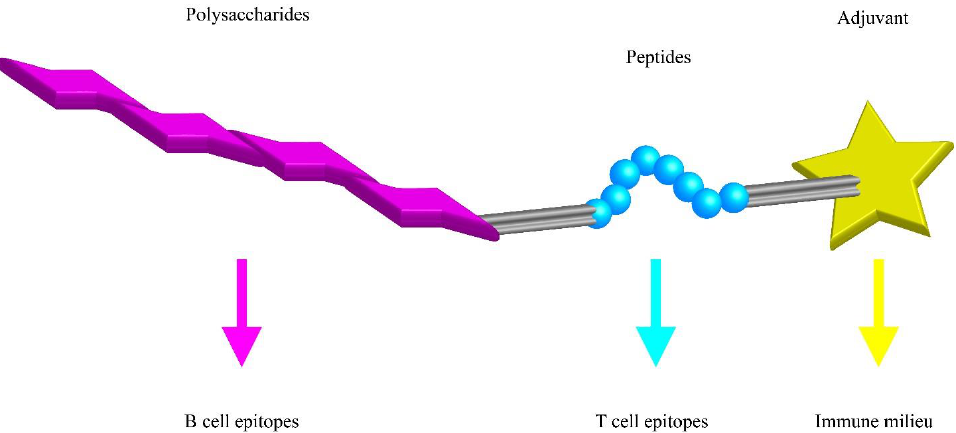
Figure 3. Synthetic polysaccharide vaccine building blocks. A minimal polysaccharide (PS) vaccine needs to provide the B and T cell epitope together with an adjuvant that determines the nature of the immune response. Peptides are used as example where classic T cells would help B cells.